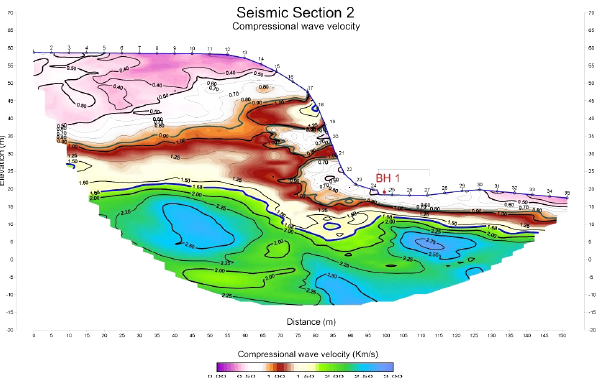
Fig. 9. Seismic survey, section 2 attenuation coefficient. The anal- ysis of this parameter defines the degradation and fracturing of the rock mass. We can notice detensioned material areas towards the top edge of the escarpment (red colour). At the foot of the slope (geophones 21–24), an area with poor mechanical properties un- derlays a sector with very poor mechanical properties (geophones